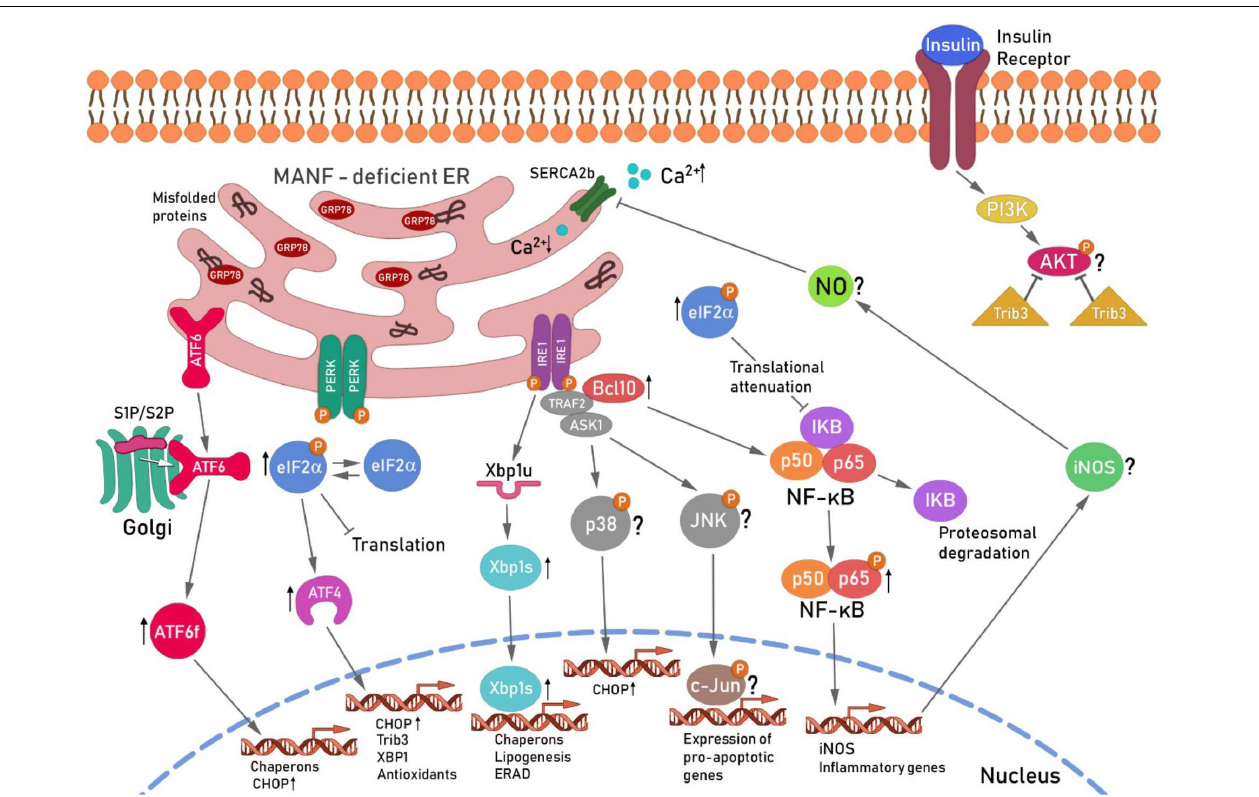
FIGURE 3 | Hypothetical scheme for the unfolded protein response-induced signaling cascade in MANF-deficient beta cells. Ablation of MANF in mouse beta cells in vivo leads to sustained UPR, increased inflammatory signaling and beta cell death. The IRE1 α pathway, Xbp1s and Chop mRNA levels were found increased in the pancreases of Manf − / − embryos at E18.5, whereas the PERK and ATF6 pathways were upregulated and chronically activated after birth in Manf − / − islets